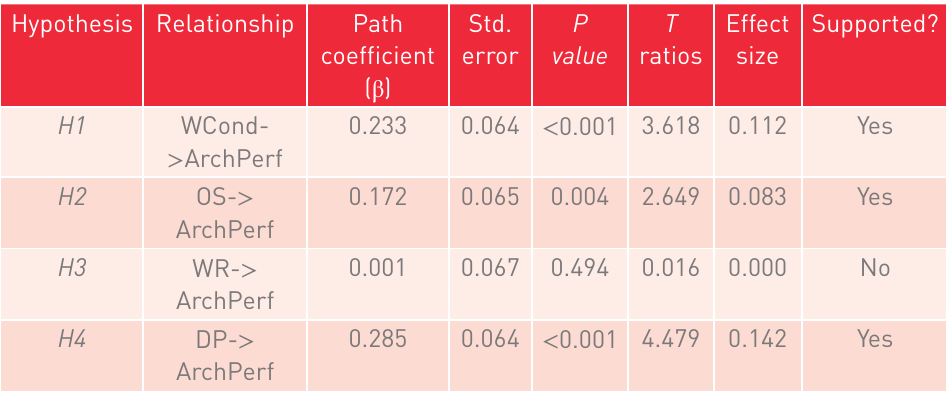
Results of the hypotheses tests Hypothesis